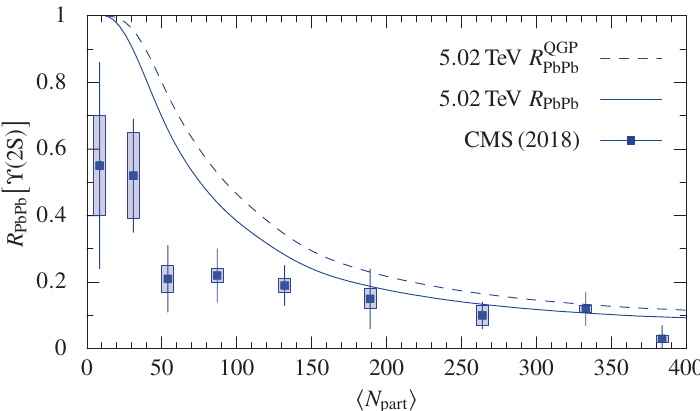
Figure 13. Suppression factor for the first excited spin-triplet state R AA ( Υ ( 2 S )) in Pb-Pb collisions at √ s NN = 5.02 TeV (solid line) together with data from CMS. The suppression factor R AA ( Υ ( 2 S )) in the QGP -phase (dashed) accounts for most of the calculated total suppression (solid) for the Υ ( 2 S ) . Theoretical predictions are from Hoelck, Nendzig, Wolschin [3], CMS data are from